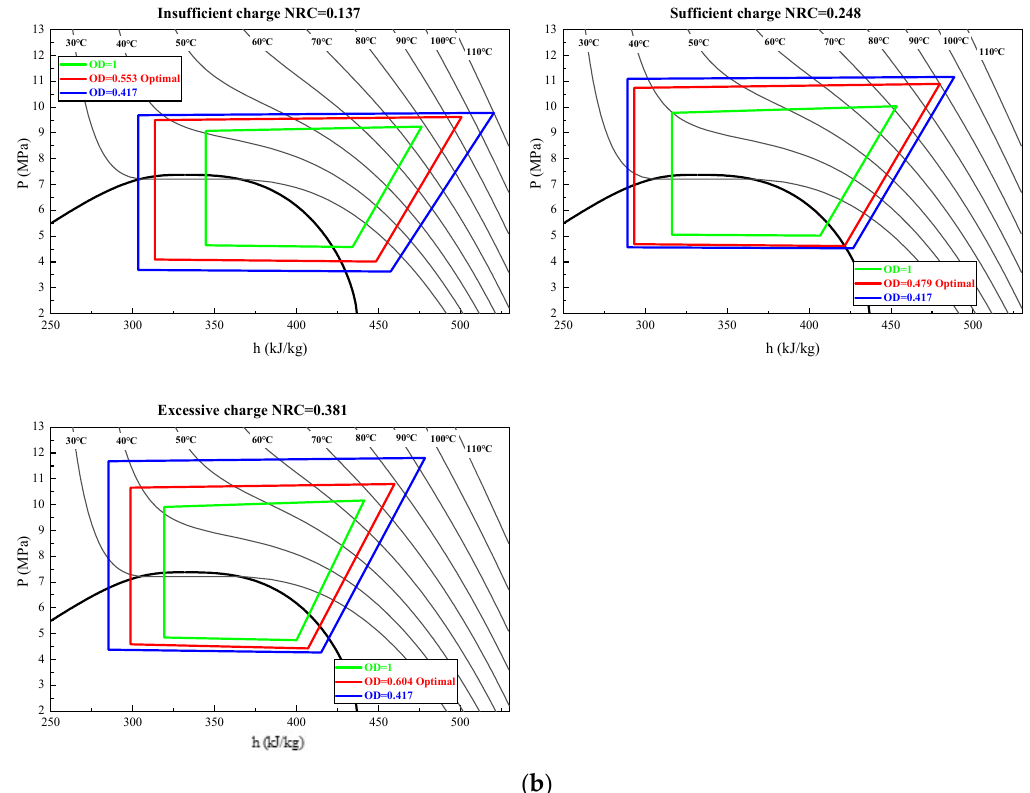
Figure 5. ( a ) Variation of COP and cooling capacity with discharge pressure and ( b ) P-h diagrams of the transcritical CO 2 system at the insufficient charge, sufficient charge and excessive charge at different EEV opening degrees (OD).